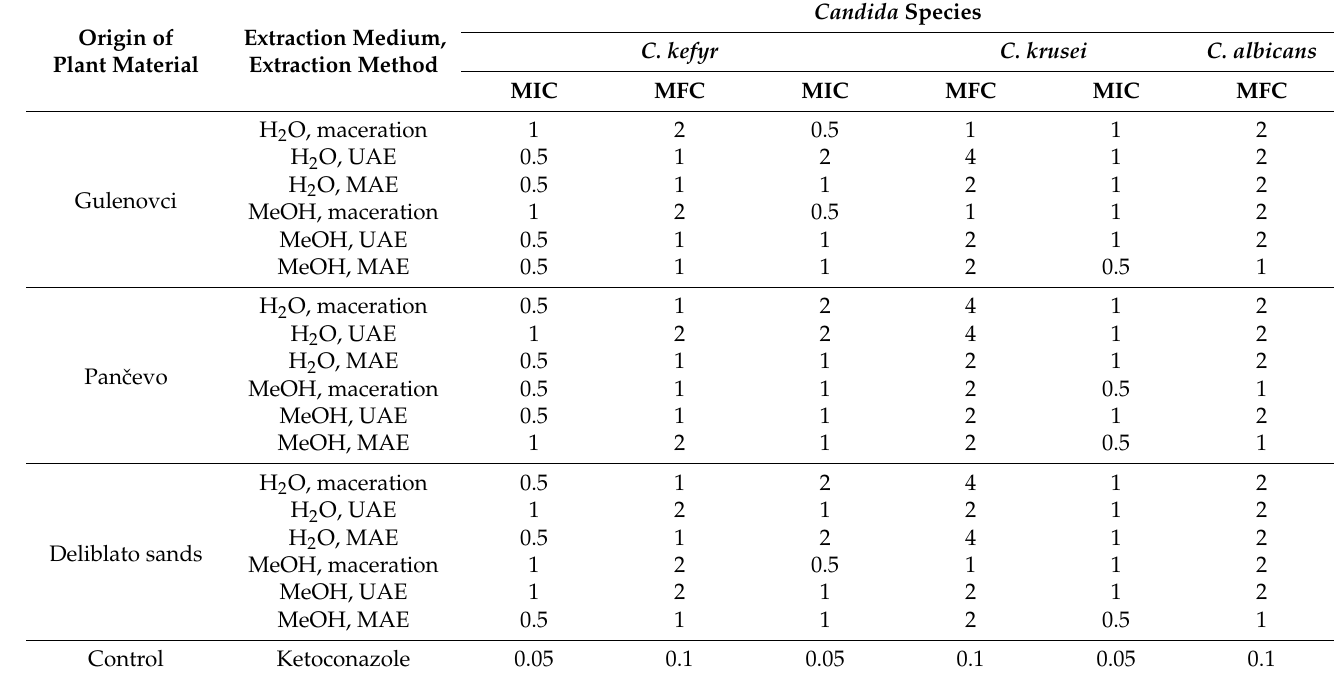
Table 4. Anticandidal activity of Paeonia tenuifolia water and methanolic extracts (MIC and MFC, mg/mL).